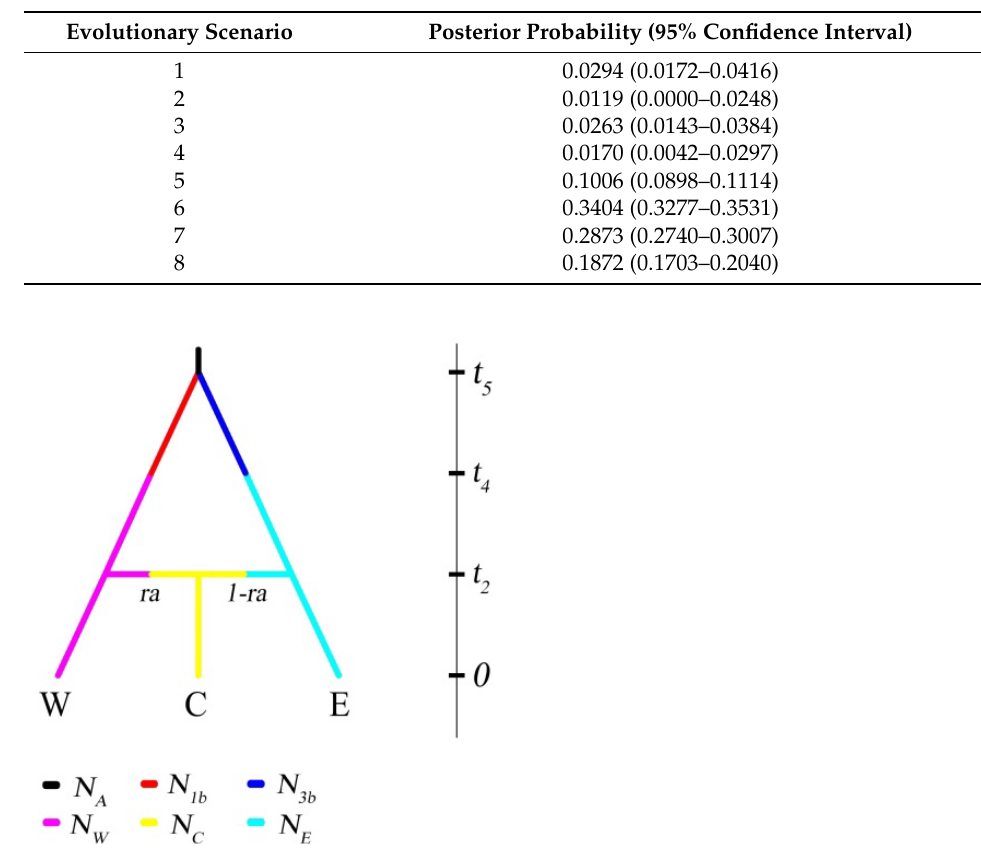
Table 6. Posterior probabilities of eight hypothesized evolutionary scenarios for the western, central, and eastern groups of Castanopsis sclerophylla .